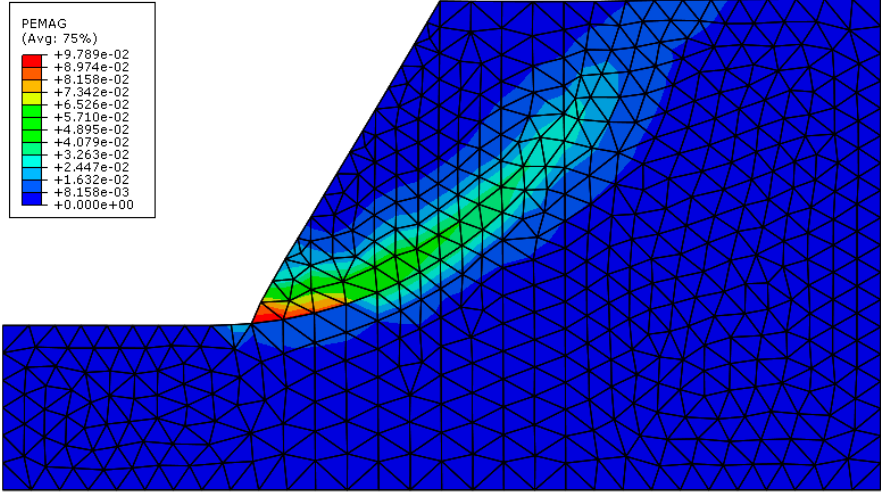
Figure 15. The plastic strain magnitude in the FEM model